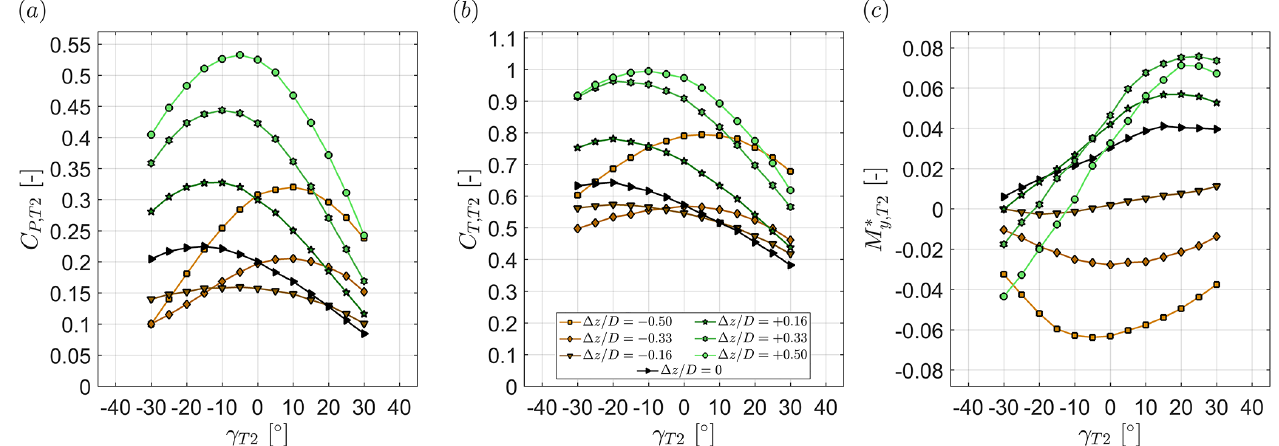
Figure 12. Downstream turbine (a) power coefficient, (b) thrust coefficient and (c) normalized yaw moment as a function of its yaw angle γ T2 for different lateral offset position (cid:49)z/D . The upstream turbine yaw angle is kept constant at γ T1 = 30 ◦ . The downstream turbine T2 is located at x/D = 3. The turbines are exposed to inflow B.